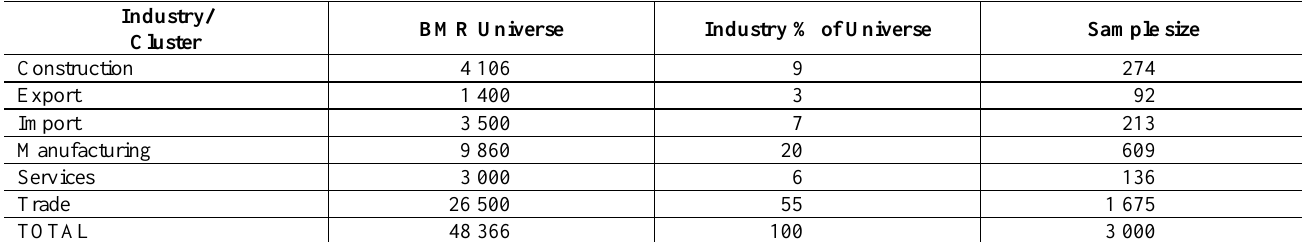
Table 6: BMR Universe and sample of Code 5 enterprises – 1999 Industry/ BMR Universe